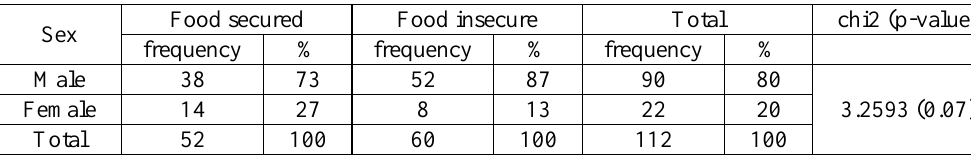
Table 2. Descriptive analysis of gender of the household head